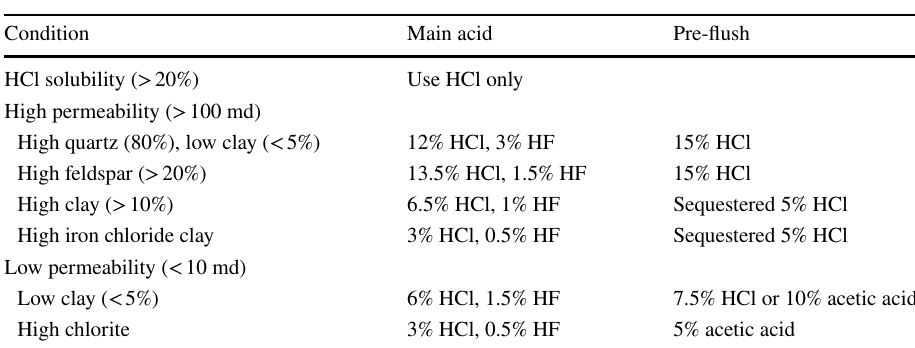
Table 3 Guideline for treatment fluid selection (Crowe et al. 1992)